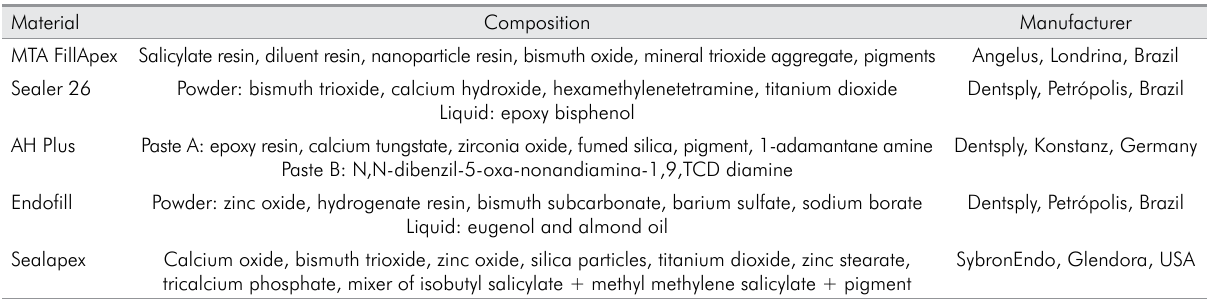
Table 1. Endodontic sealers, compositions, and manufacturers.